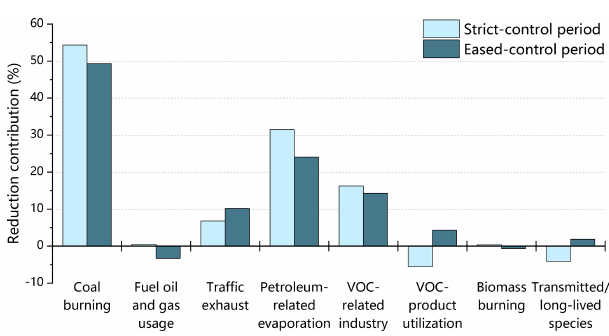
Figure 5. Different source contributions of the strict- and eased- control periods to total reduction compared with the non-control period (ratio) derived by PMF